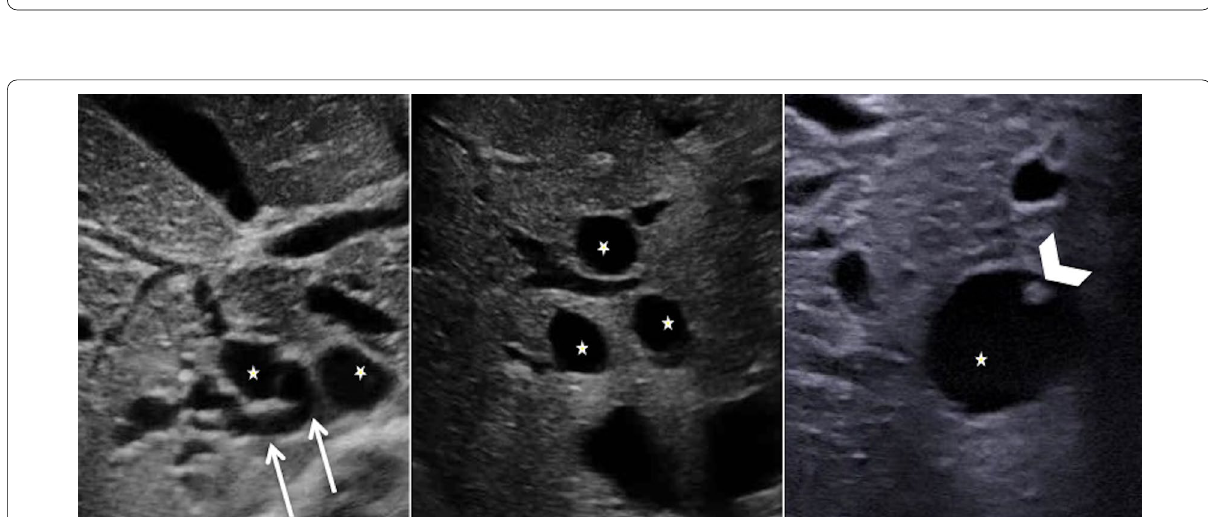
Fig. 11 Caroli syndrome in a 7-year-old female, at ultrasonography. Several round anechoic cysts (stars) with thin wall, increased through-transmission, connected to the dilated fusiform biliary tract (arrows), some of which show the highly specific “central dot sign”